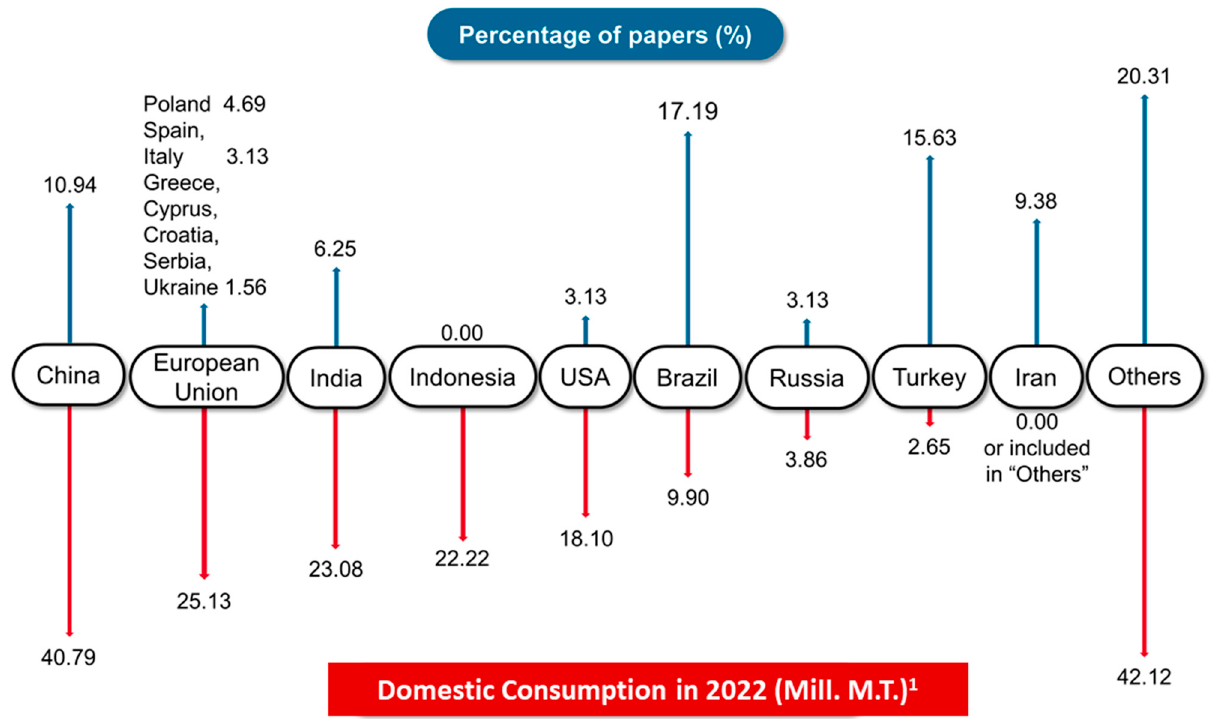
Figure 1. Percentage of studies per country related to the presence of heavy metals in edible vegetable oils and global domestic consumption in December 2022. 1 Data expressed in million metric tons.